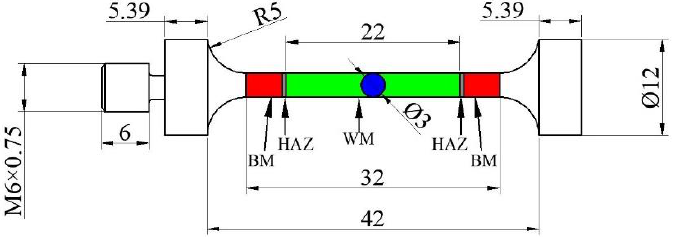
Figure 2. Shape and dimension of cross-welded ultrasonic fatigue specimen (mm).